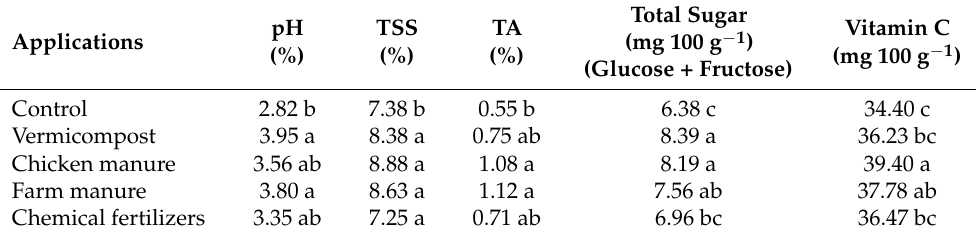
Table 5. Effects of fertilizer applications on fruit quality